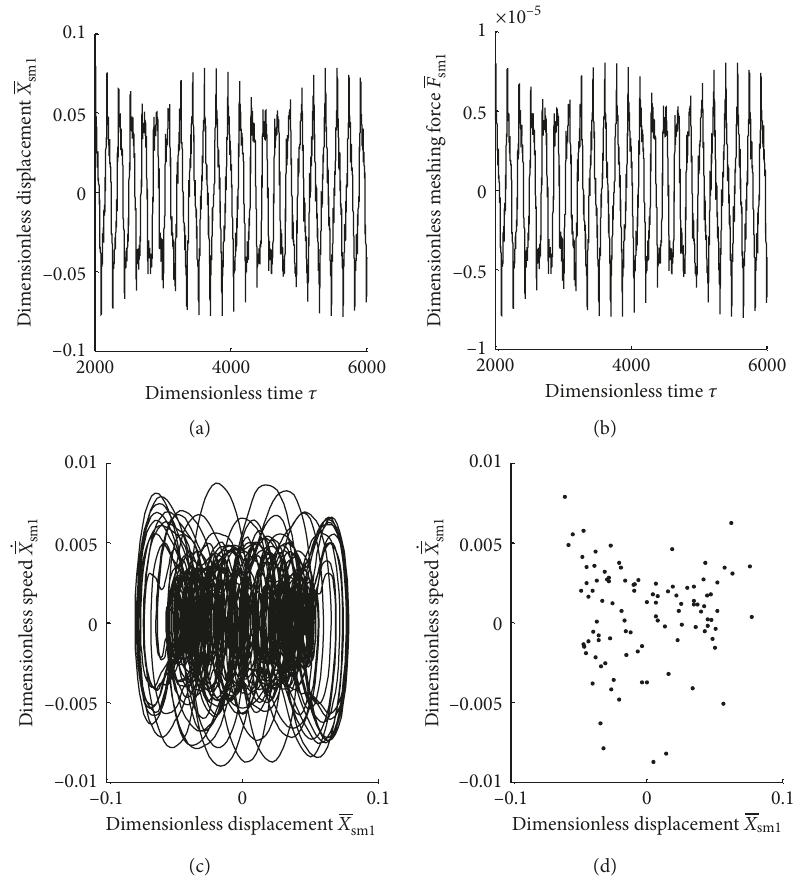
Figure 10: Process diagrams of response, phase diagram, and Poincar´e section under b process diagram of displacement response. (b) Time process diagram of meshing force response. (c) Phase diagram. (d) Poincar´e section.